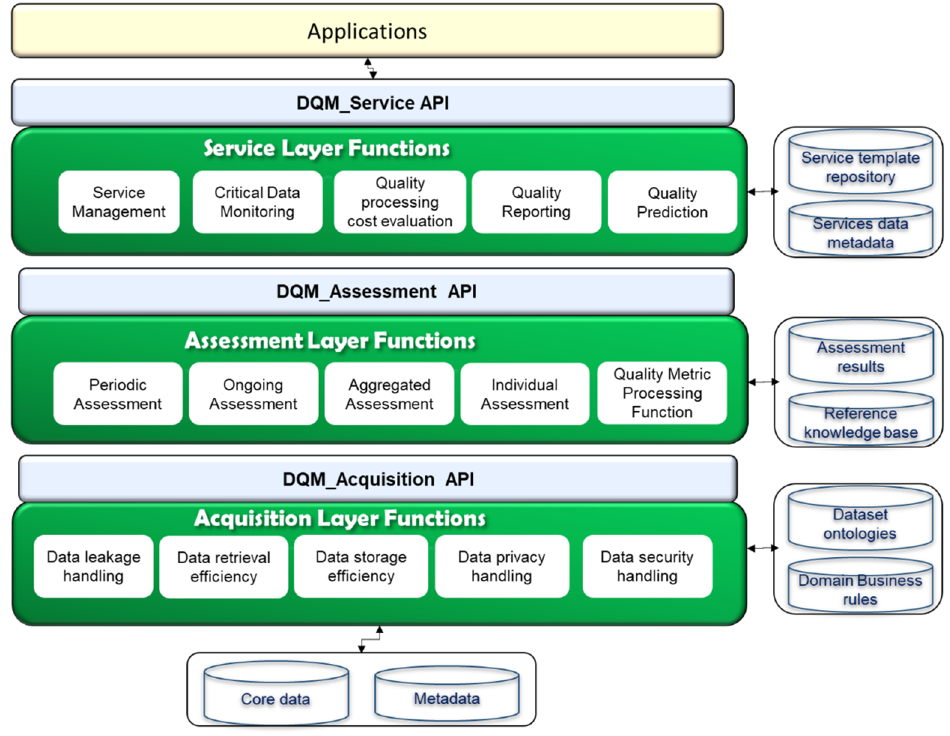
Figure 3. Layered model of data quality assessment.